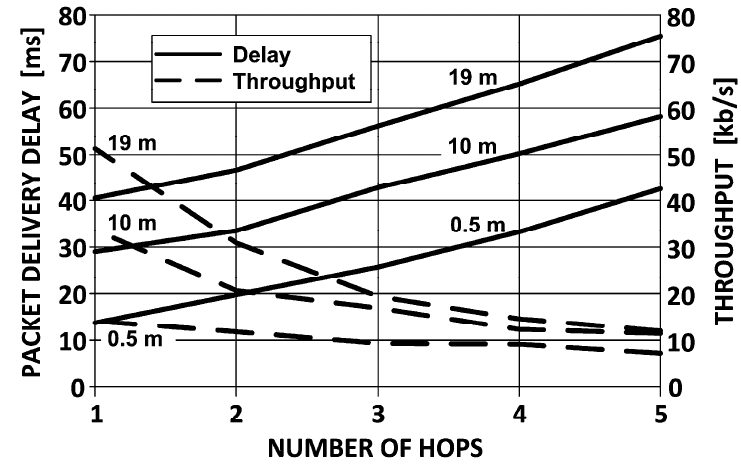
Figure 13. Measured ZigBee performance under multi-hop conditions: throughput and packet delivery delay.